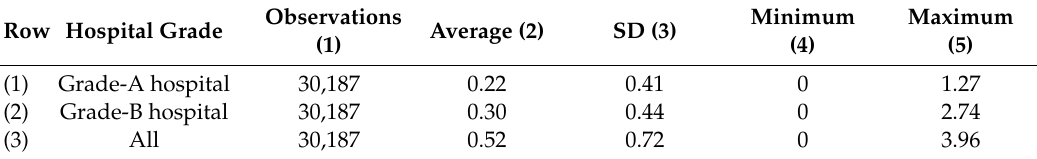
Table 2. Descriptive statistics of accessibility ratios of rural residents in Hubei